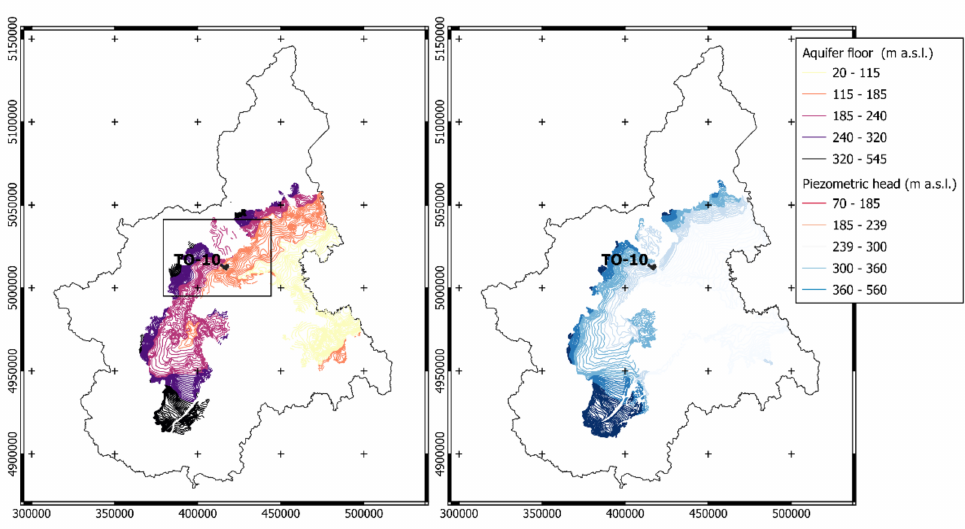
Figure 7. Maps showing the available AF ( left ) and PH ( right ) layers as obtained from the Piemonte Region geoportal. Reference system is WGS84 UTM 32N.